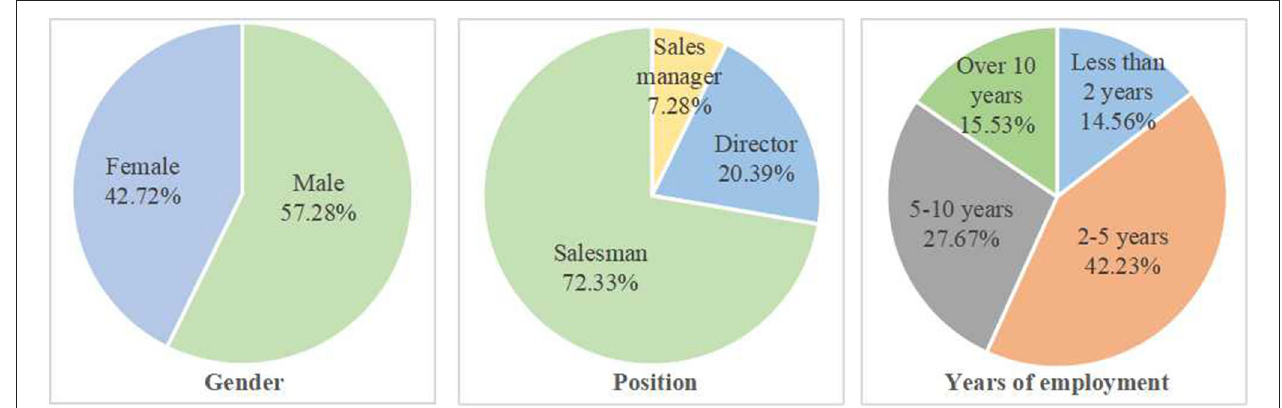
FIGURE 2 | Sample statistical distribution